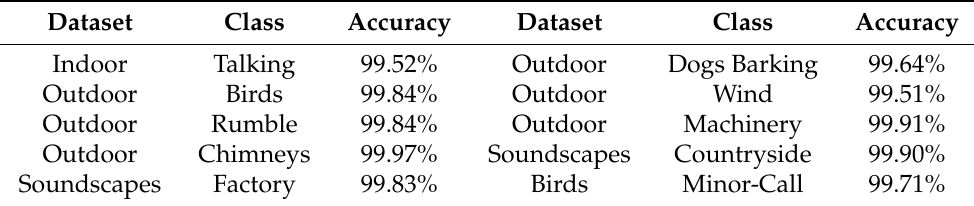
Table 7. Complete list of classes with a higher than 99.5% accuracy